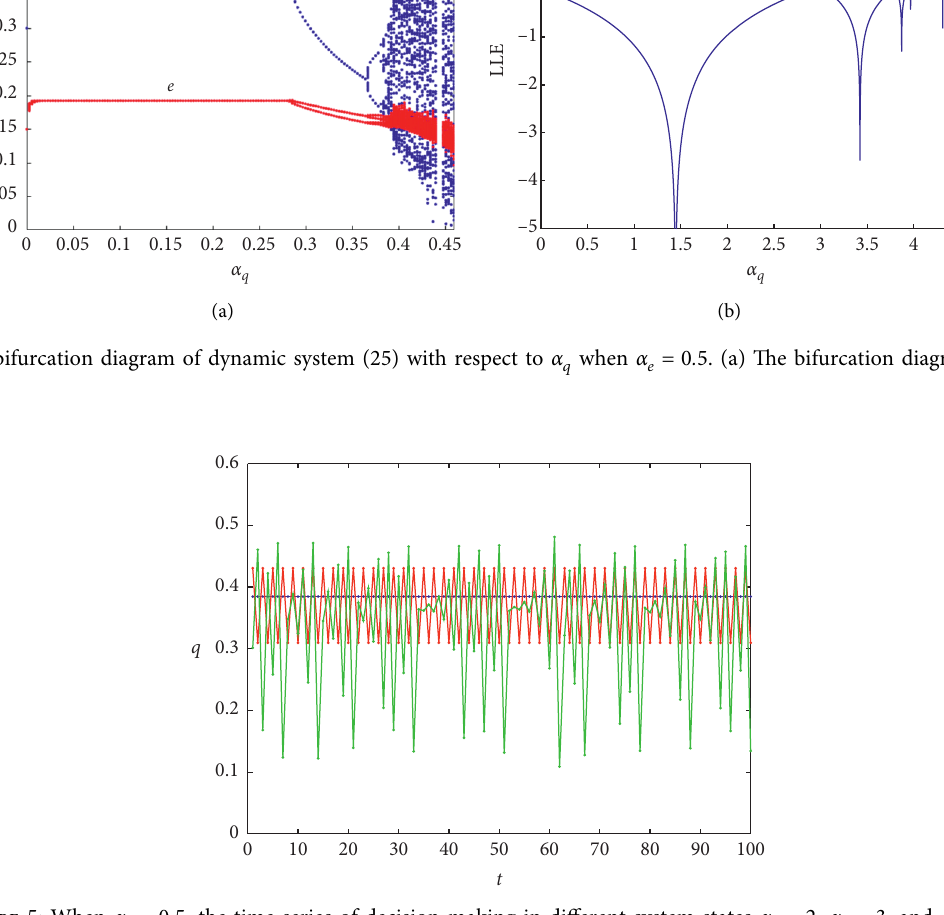
� 0 . 5, the time series of decision-making in different system states α e